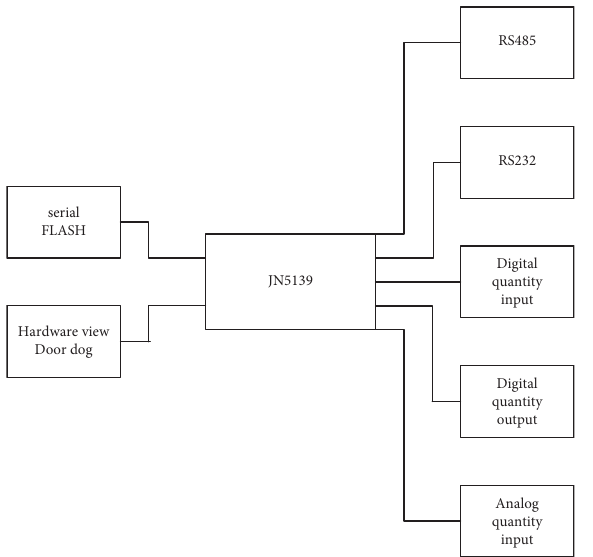
Figure 4: Specific block diagram of JN5139